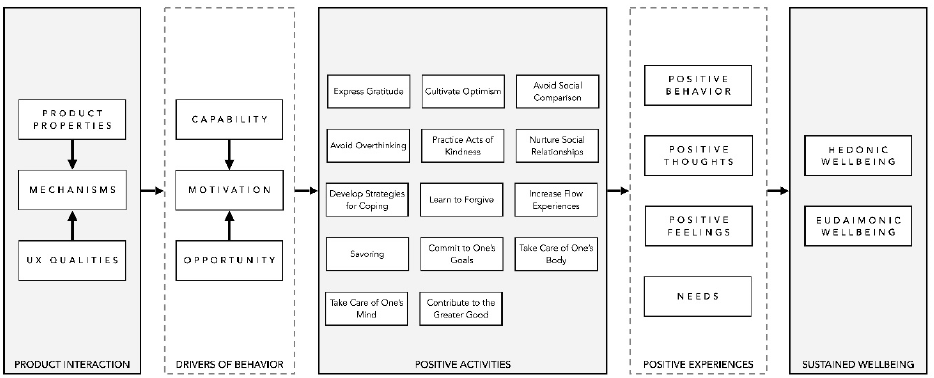
Figure 1. The multi-stage framework for sustained wellbeing promoted by technology. Pillar 2 (drivers of behavior) and pillar 4 (positive experiences) have a dashed outline to indicate they represent mediating stages in the process (see text for explanation).